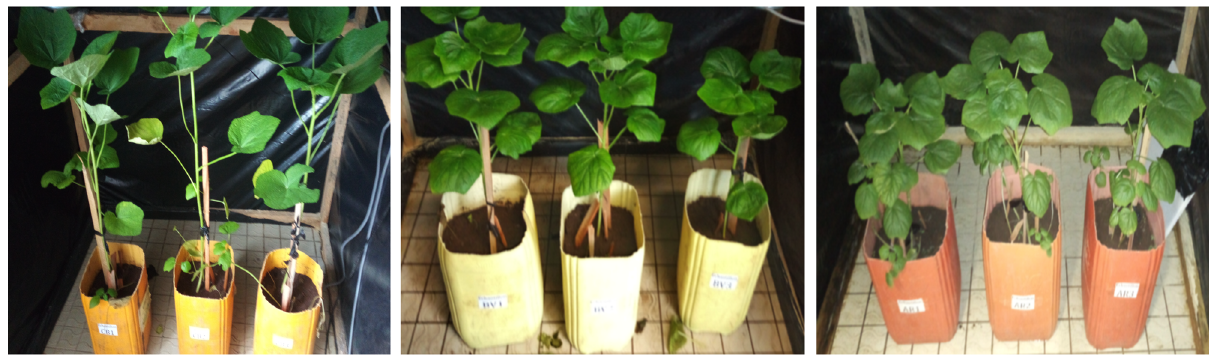
Figure 3: Okra ( Abelmoschus esculentus L. ) plants 54 days after sowing. From left to right, respectively, okra plants treated under blue, green, and red light.